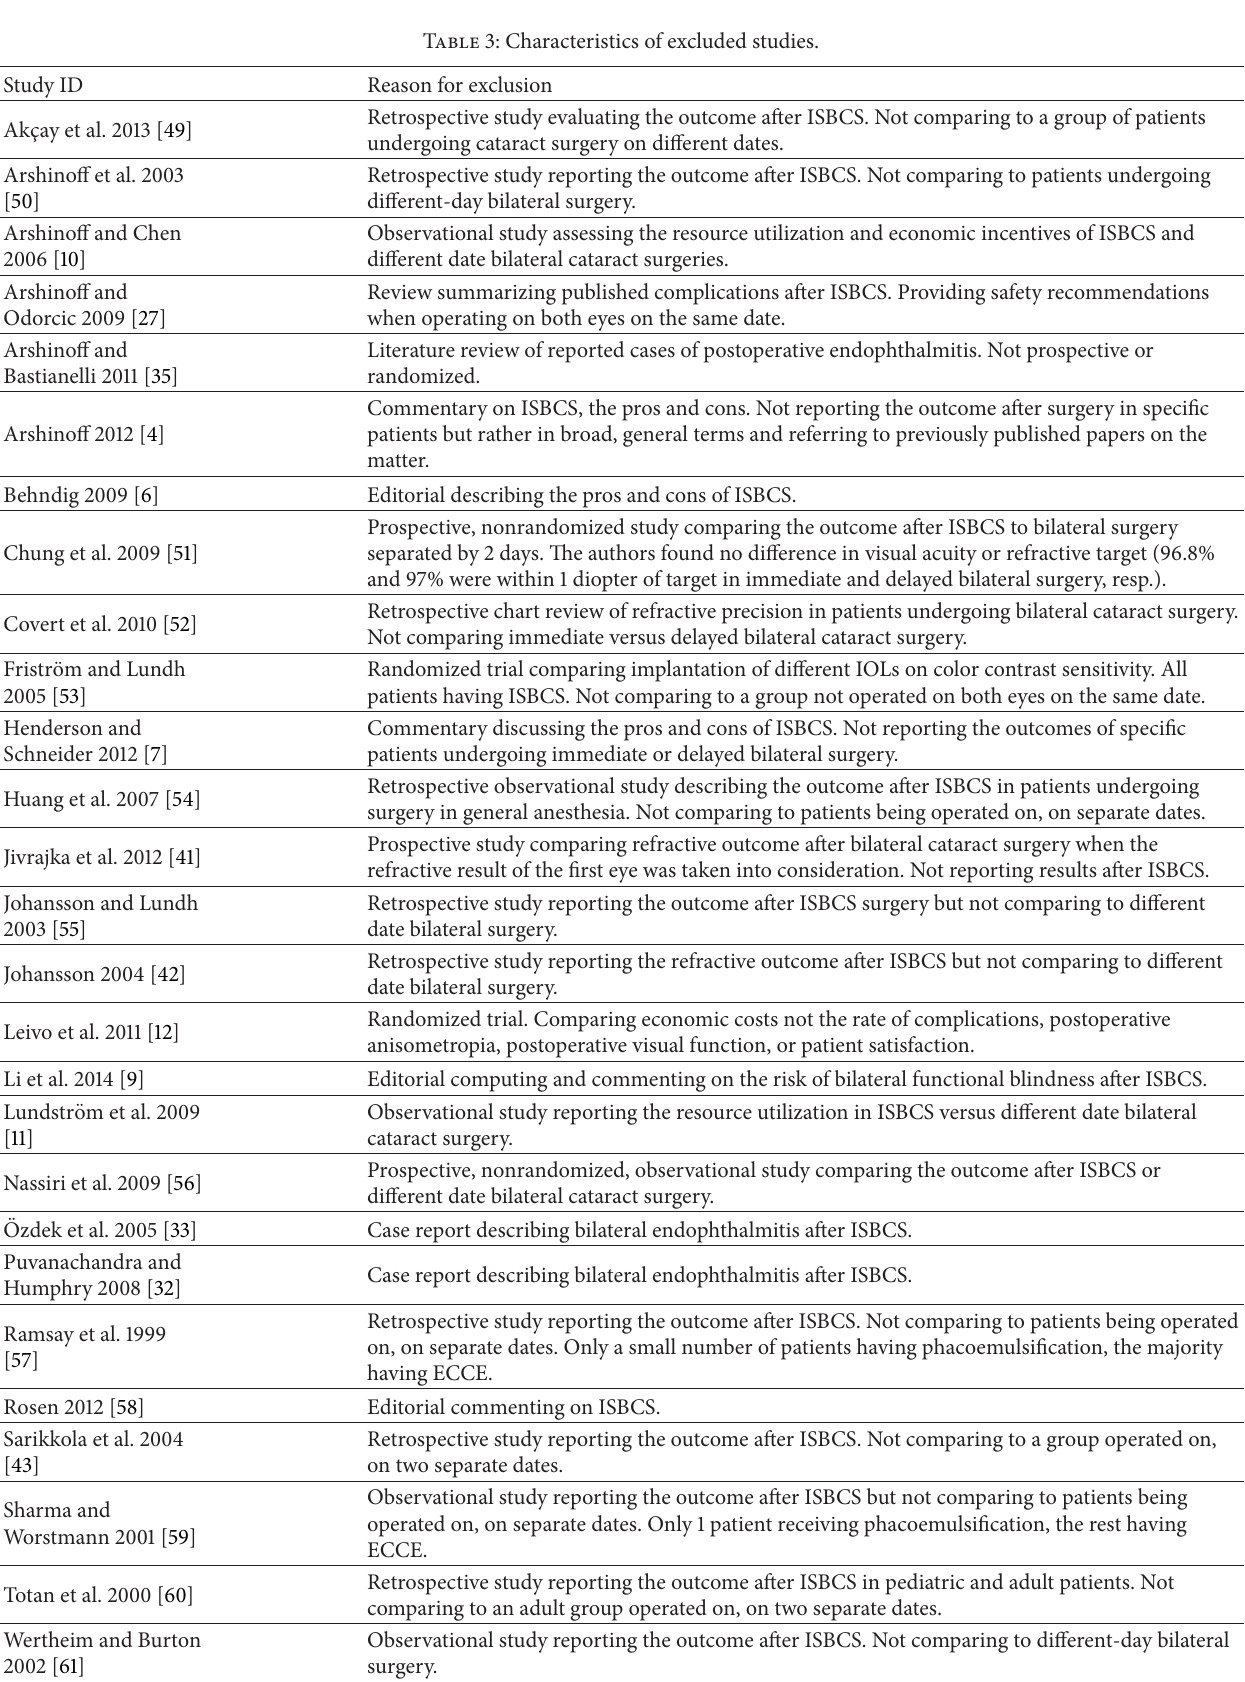
Table 3: Characteristics of excluded